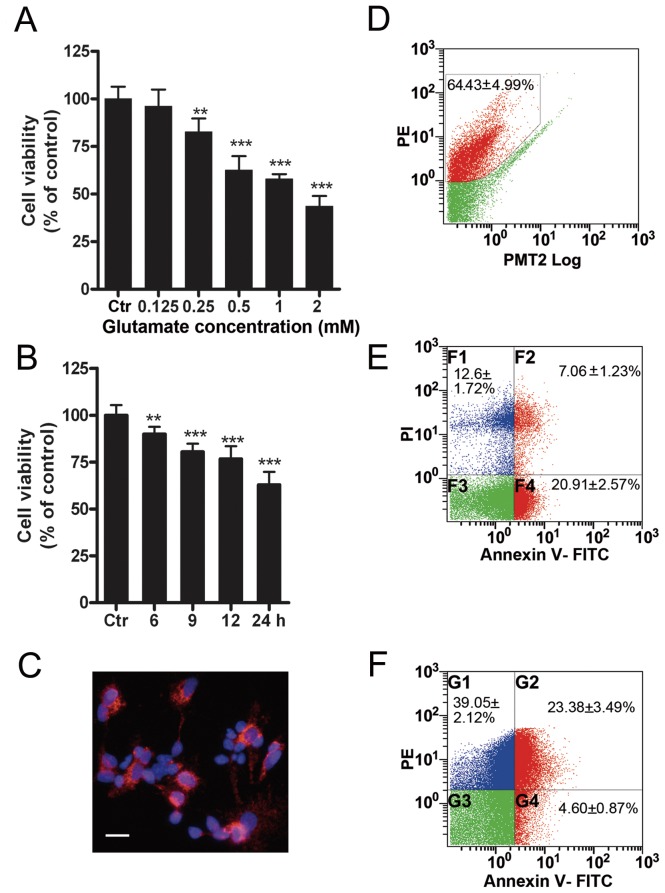
Glutamate-induced injury in cultured rat retinal neurons.(A) Glutamate treatment for 24 h [GT (24 h)] decreased the cell viability in a concentration-dependent manner. Cell viability was assayed by MTT method. Data are normalized to control (Ctr). n = 9 for each group, ** p<0.01, *** p<0.001 vs Ctr, one-way ANOVA. (B) Cell viability was decreased in a time-dependent manner following 0.5 mM GTs (6 h, 9 h, 12 h, 24 h), assayed by MTT method. n = 9 for each group, ** p<0.01, *** p<0.001 vs Ctr, one-way ANOVA. (C) Retinal ganglion cells (RGCs) were immunostained with Brn-3a antibody. Scale bar: 20 µm. (D) Flow cytometry analysis shows Thy1.1-positive RGCs (red, in the black polygon) in cultured retinal cells. n = 6. (E) Annexin V-FITC flow cytometry shows cell apoptosis (red) in cultured retinal cells after GT (24 h). F2 and F4 are the apoptotic cells at early and late phases respectively. n = 6. (F) Annexin V-FITC and PE-Thy1.1 flow cytometry shows cell apoptosis (red) of the PE-Thy1.1 staining RGCs. G2 and G4 are the apoptotic RGCs at early and late phases respectively. n = 6.